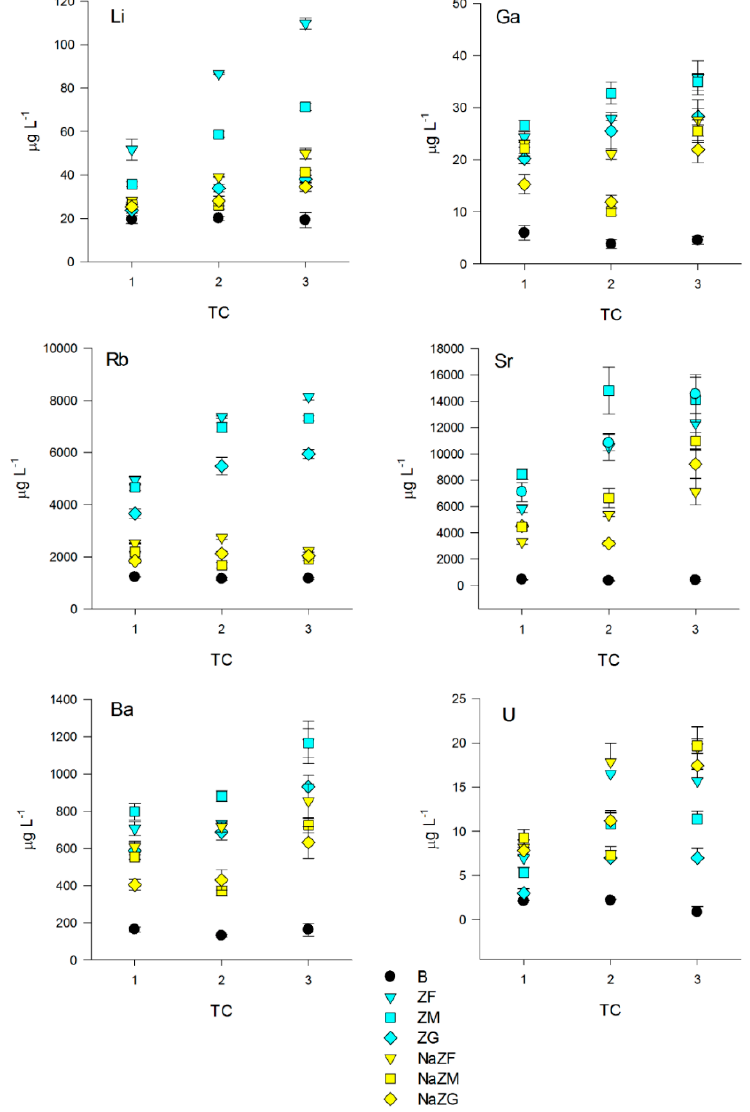
Figure 6. Dynamics of Li, Ga, Rb, Sr, Ba, and U among the three treatment cycles (TC) of the pig-slurry treated with natural ZTs in three grain sizes (ZF = grain size 0.1-0.7 mm, ZM = grain size 0.7-2.0 mm and ZG = grain size 2.0-5.0 mm) and Na-homoionic NaZTs in three grain sizes (NaZF = grain size 0.1-0.7 mm, NaZM = grain size 0.7-2.0 mm, and NaZG = grain size 2.0-5.0 mm)and in the blank samples (without the addition of ZTs).